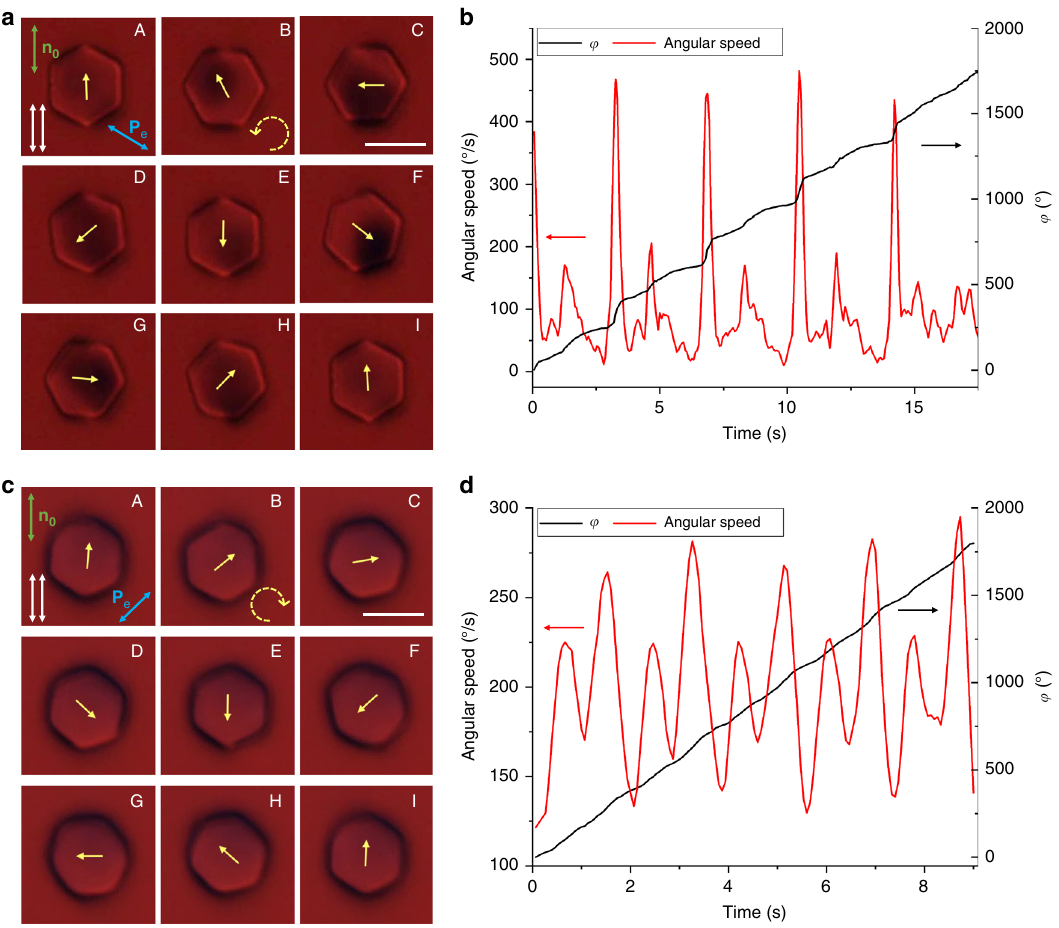
Fig. 7 Particle spinning for polarizations of excitation light at θ ≈ − 60° and θ ≈ 45°. a , c Sequences of images showing a micro-platelet at different orientations during one rotation period under polarization of excitation light at θ ≈ − 60° a and θ ≈ 45° c . Polarizing optical images were taken under parallel polarizers shown with two adjacent white double arrows. Polarization direction of the blue excitation light is shown using a blue double arrow. The particle rotates counterclockwise a and clockwise c , as indicated by the yellow dashed arrow. Its angular positions in each image are shown using yellow arrows. Scale bars are 5 µ m. b , d The net azimuthal rotation angle φ (black curve) and angular speed (red curve) versus time during fi ve periods of platelet rotation corresponding to platelet rotation shown in a and c ,